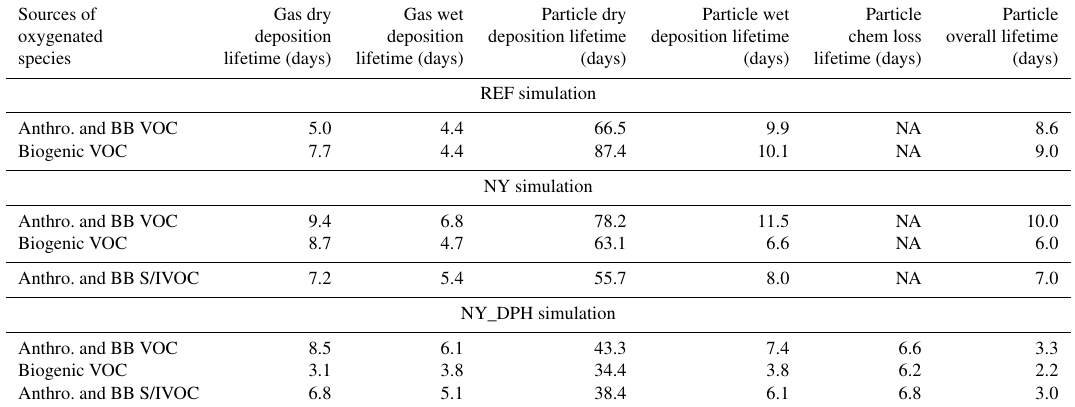
Table 6. Global annual-average lifetimes for organic gases and particles for the 4-year (2005–2008) period. VOC from anthropogenic, biomass burning (BB) and biogenic sources are indicated, as well as S/IVOC from anthropogenic and BB sources. Sources